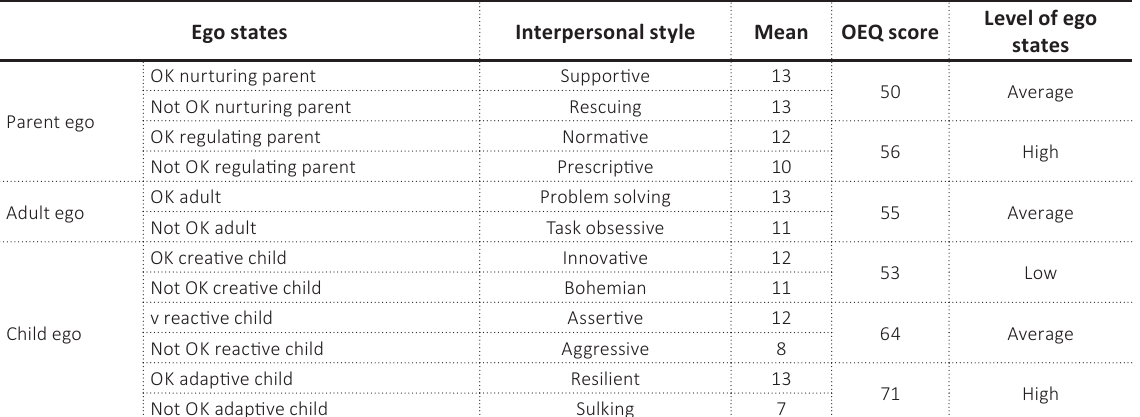
Table 6. Overall level of ego